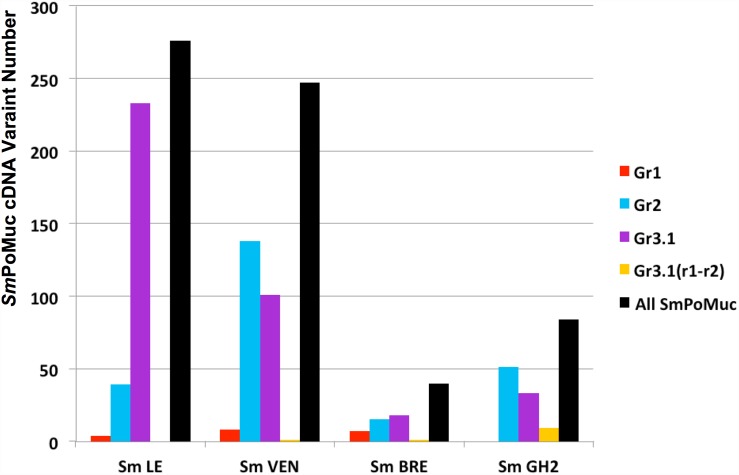
SmPoMuc variant numbers in the different S. mansoni strains.Nested RT-PCR for SmPoMucs was performed on 11 individual sporocysts for each S. mansoni strain (SmLE, SmVEN, SmBRE, and SmGH2), and the obtained fragments were cloned and analyzed by Sanger sequencing (see S1 Table). The numbers of SmPoMuc cDNA variants obtained for group 1 (red), group 2 (blue), group 3.1 (purple), group 3.1(r1-r2) (yellow), and all groups (black) are indicated.